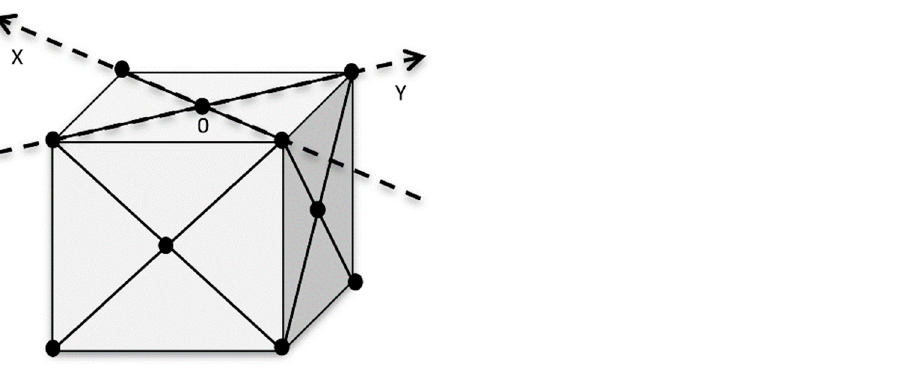
Figure 2. Model of the fcc structure as taken into consideration for the incident beam azimuth [110].